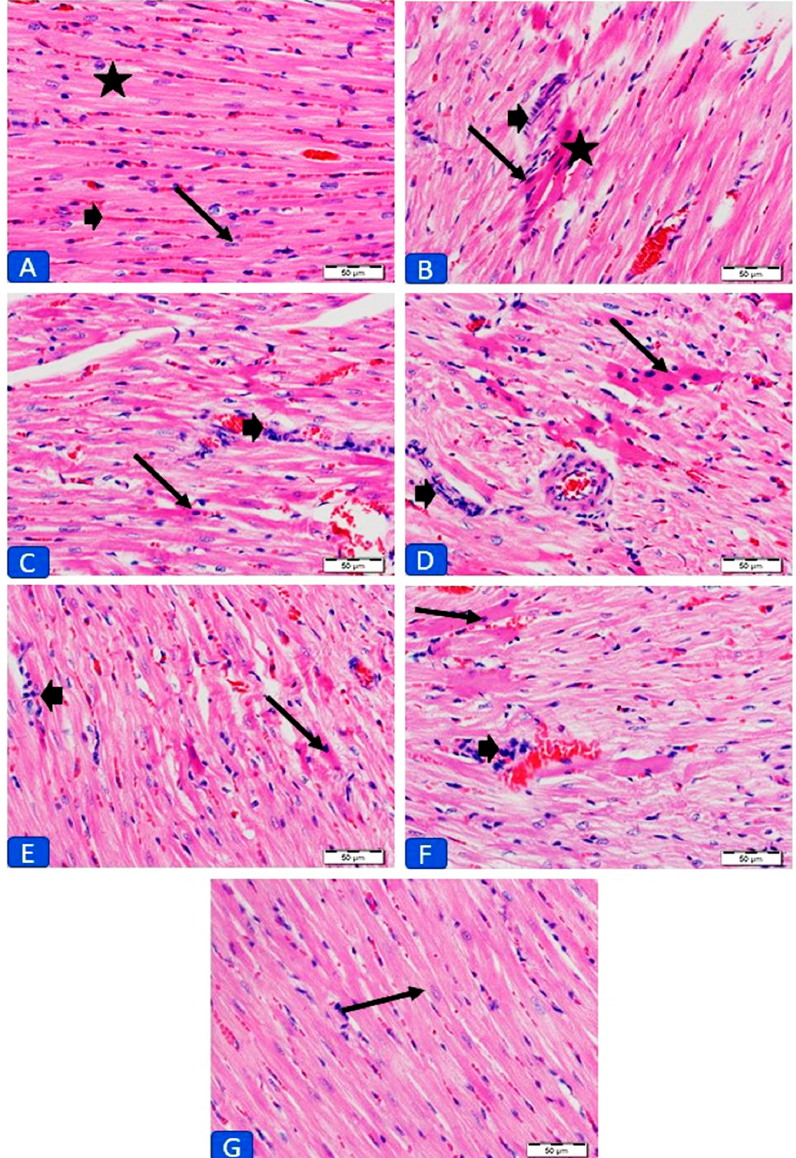
Figure 2. Photomicrographs of sections in the left ventricles (LV) of ( A ) control rats showing normal histology of cardiomyocyte cytoplasm (star) and nuclei (arrows) and normal distribution of endomysium (bold arrow). ( B ) DOX-intoxicated rats showing foci of degenerated cardiomyocytes and collection of inflammatory cells in the endomysium (bold arrow). ( C ) CAR-treated rats showing mild improvement of myocardium with less degeneration (arrow) and inflammatory cells (bold arrow). ( D ) RES-treated rats showing foci of degenerated cardiomyocytes (arrow) and few inflammatory cells (bold arrow). ( E ) CAR/RES- and ( F ) LIPO-RES-treated rats showing moderate decrease in degeneration (arrow) and inflammatory cells (bold arrow); and ( G ) CAR/LIPO-RES-treated rats with no degeneration or inflammatory cells and the cardiomyocytes appear normal. ( × 400; H&E; scale bar: 50 µ